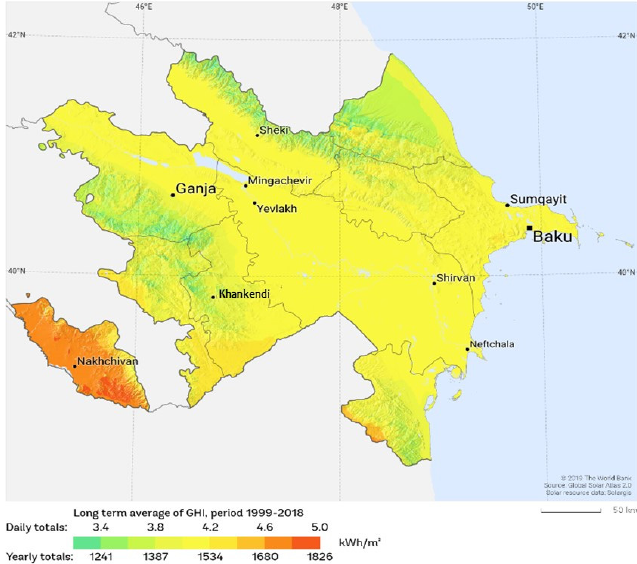
Figure 6. Global Horizontal Irradiation map of Azerbaijan [26].